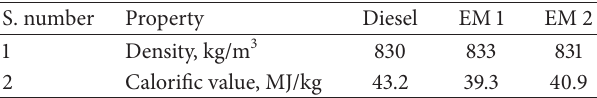
Table 1: Comparison of properties of fuel.